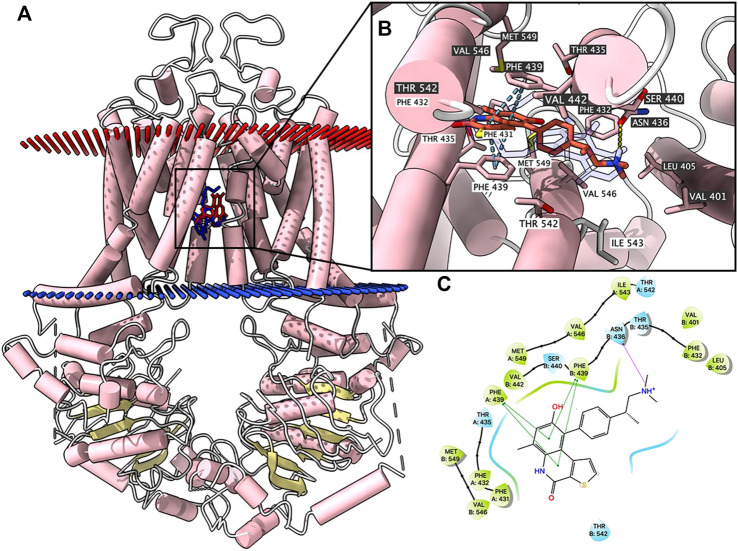
Highest scoring docked pose of OTS964 within human ABCG2 at substrate-binding site. (A) Overview of mitoxantrone and best-scoring pose of OTS964 in drug-binding pocket of ABCG2 protein. Mitoxantrone and OTS964 are displayed as colored sticks, blue: mitoxantrone; red: OTS964. (B) Details of interactions between OTS964 and ABCG2 binding pocket. Predicted bonds are displayed as colored dash lines: hydrogen bond: yellow; pi-pi stacking: blue. Labels with white or black background indicate chain A or B, respectively. (C) 2D OTS964-ABCG2 interaction. Important amino acids are displayed as colored bubbles (green: hydrophobic; blue: polar). Predicted bonds are displayed as colored lines: green line: pi-pi stacking; purple line with arrow: hydrogen bond.